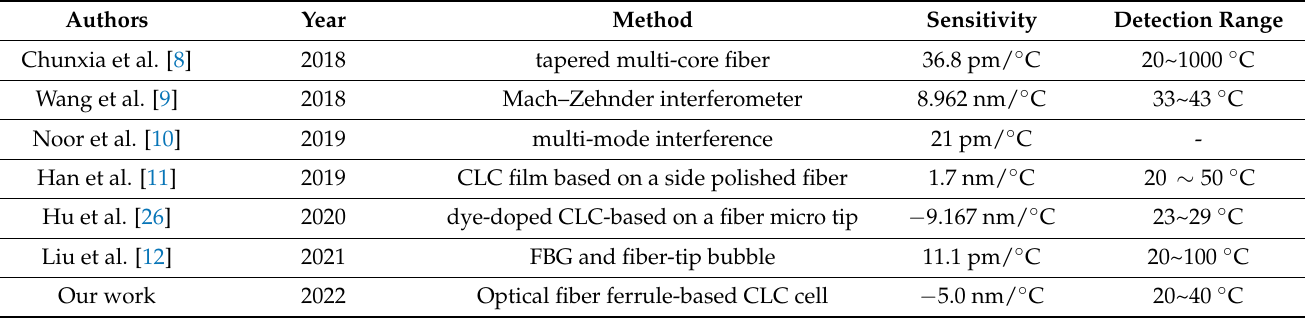
Table 1. Comparison of recent research